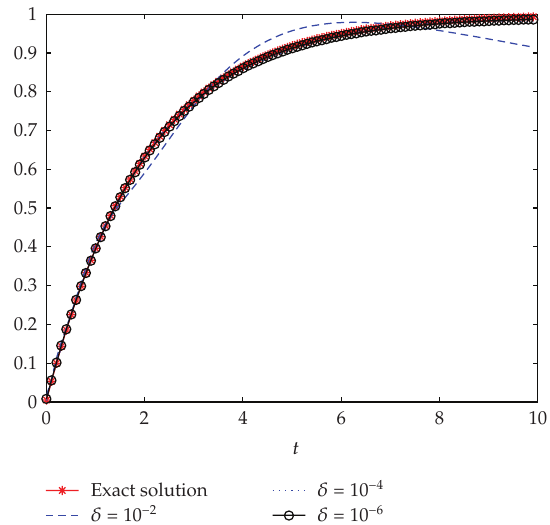
Figure 4: Example 3.4: the stability of the approximate solution.